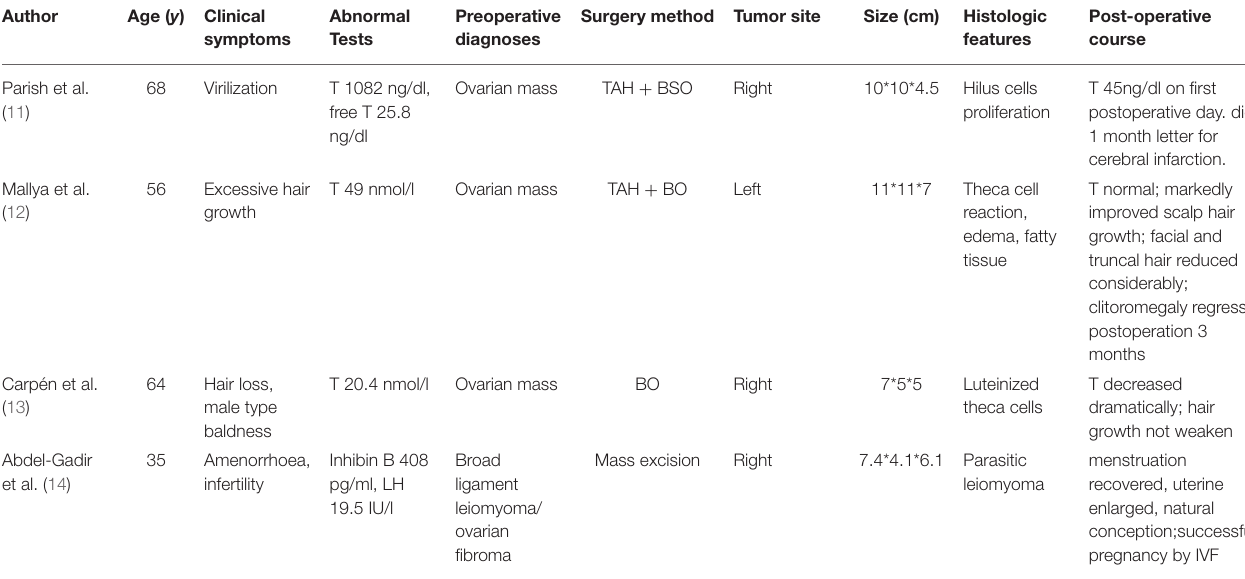
TABLE 5 | Characteristics of ovarian leiomyoma with abnormal hormonal synthesis. Author